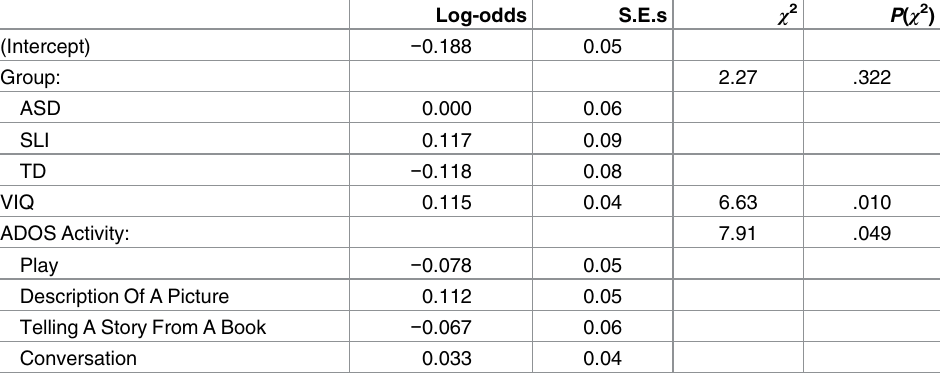
Table 6. Results for regression on false starts versus repetitions and